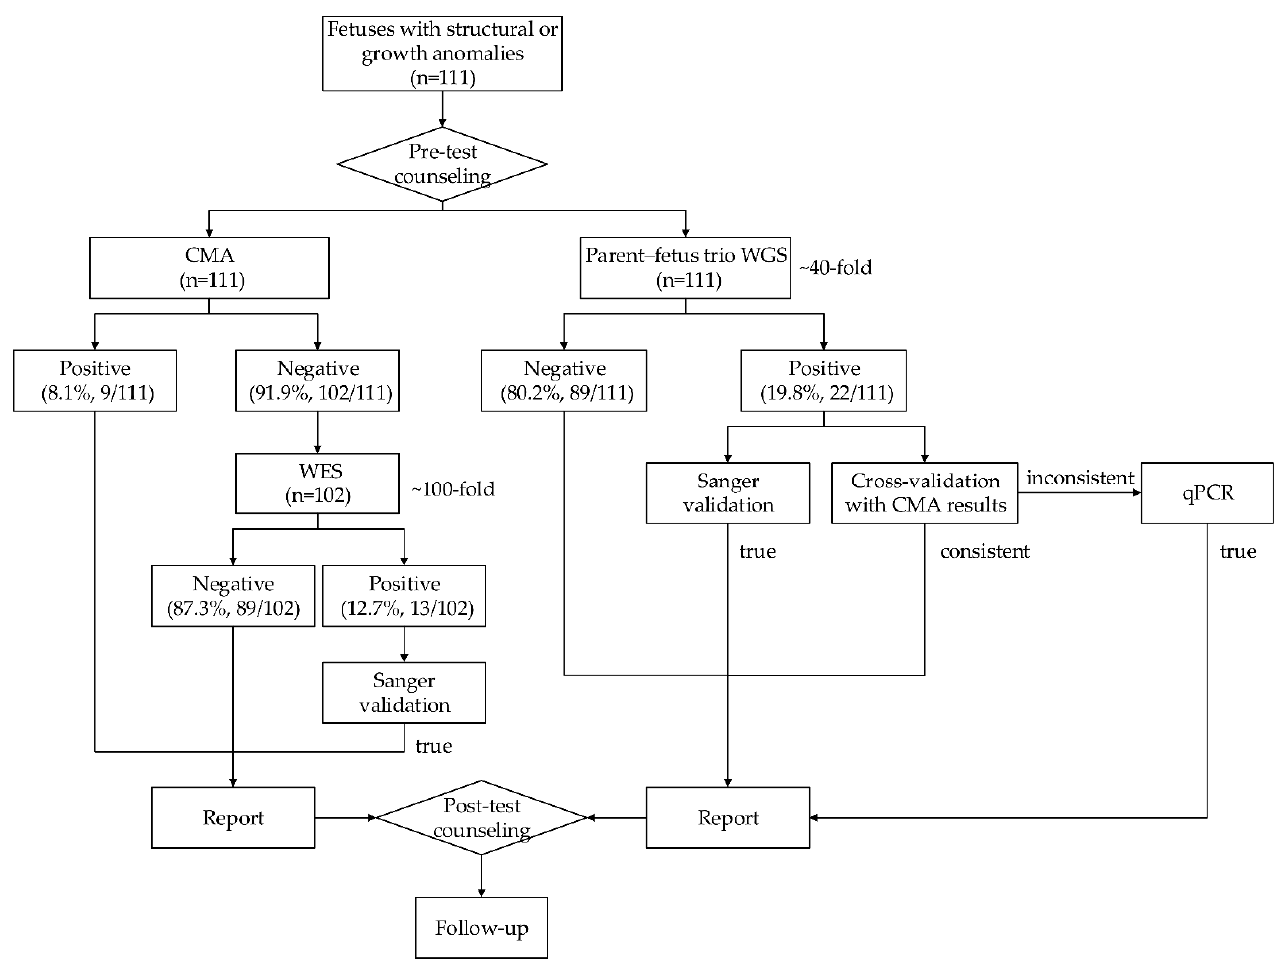
Figure 1. Flowchart of the study. A total of 111 fetuses with structural or growth anomalies were subjected to two test strategies: trio genome sequencing (whole genome sequencing (WGS)) and chromosomal microarray (CMA) plus exome sequencing (whole exome sequencing (WES)). WES was sequentially performed in only 102 fetuses with negative CMA results. The positive/negative rates are provided in each box.